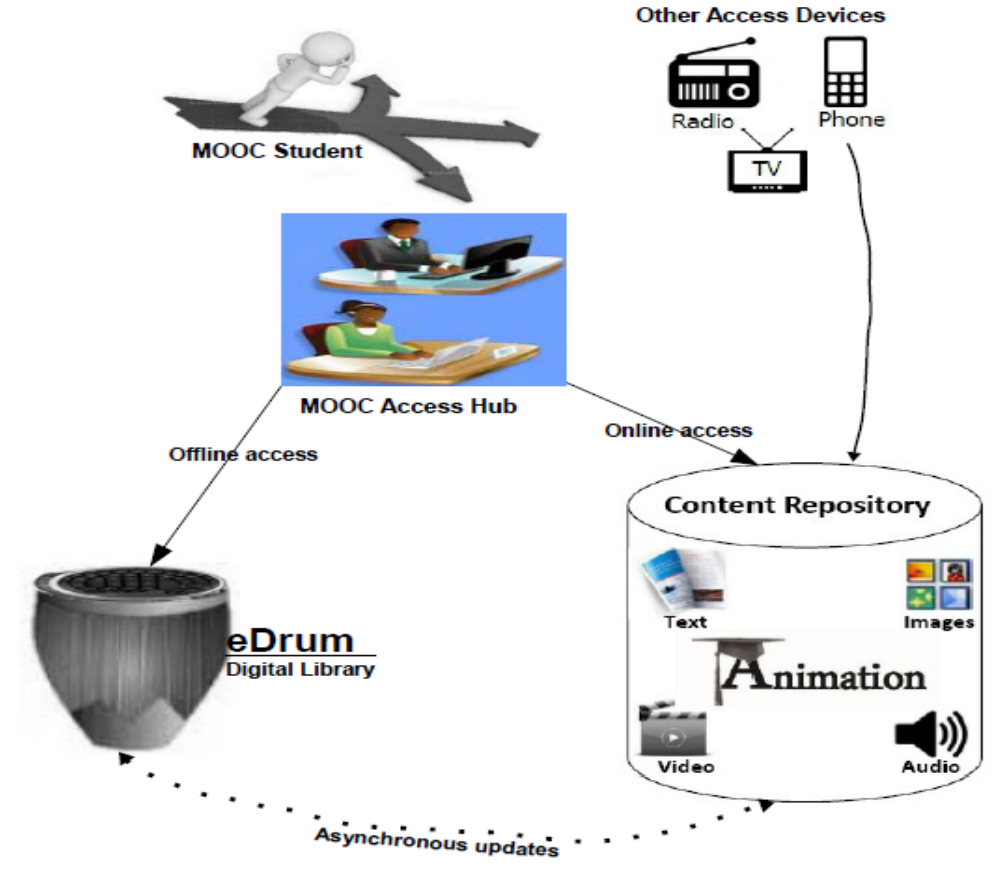
Figure 2. Access options for MOOC